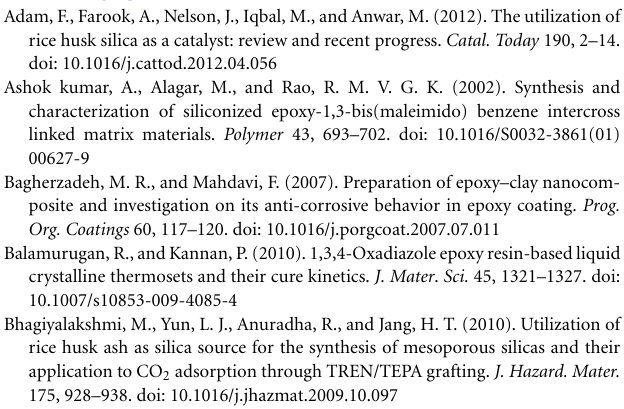
the dark portion of the pictures are due to the homogenous dis- persion of rice husk ash and BMI into the epoxy matrix without any crack. No accumulation mode was observed in the parti- cle number size distribution, the particles on the left top corner were clearly visible which indicates the presence of rice husk ash reinforcement and bottom corner represents BMI